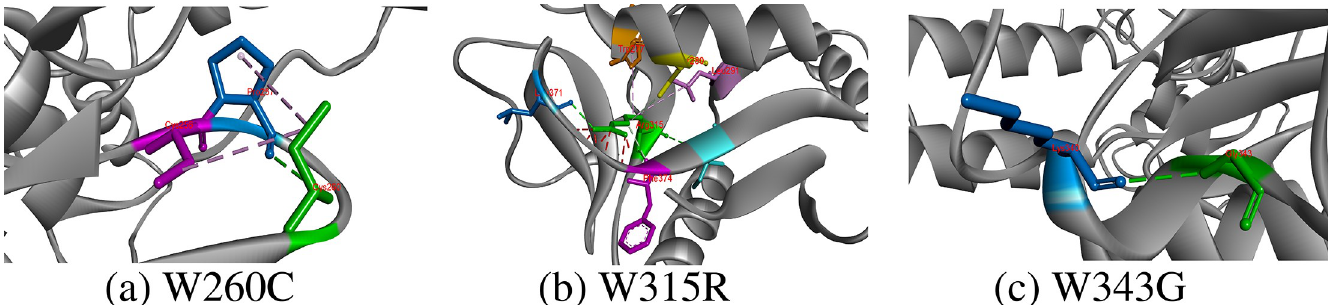
Fig 7. Hydrogen bond and other hydrophobic and electrostatic interactions created by substituted residues at 260, 315 and 343 positions in CD-209 model.